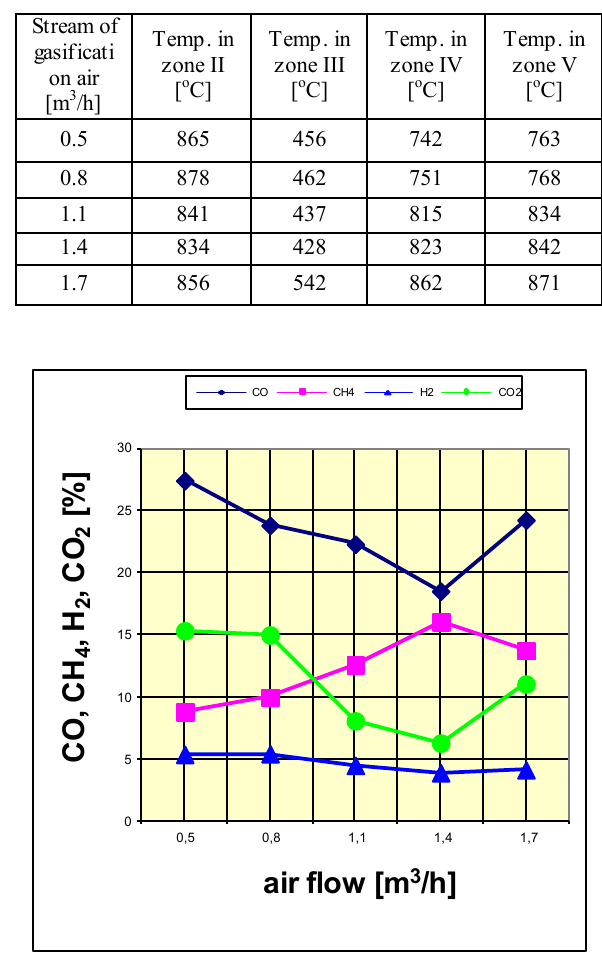
Table 2 . Temperature distribution in the gasifier